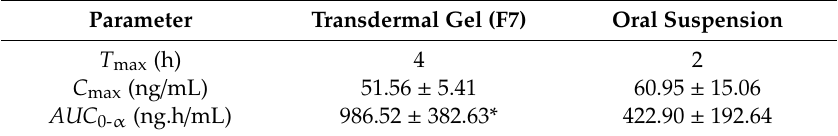
Figure 8. Plasma profiles of nebivolol at various time intervals in transdermal (gel F7) and oral administration in rats. Data expressed as average ± SD (n = 6). Table 5. Pharmacokinetic parameters of nebivolol in plasma following transdermal and oral administration in rats. T max , time of maximum concentration; C max indicates maximum concentration; AUC 0- α , area under the plasma concentration–time curve. Data expressed as average ± SD (n = 6), and * p < 0.05 were considered as